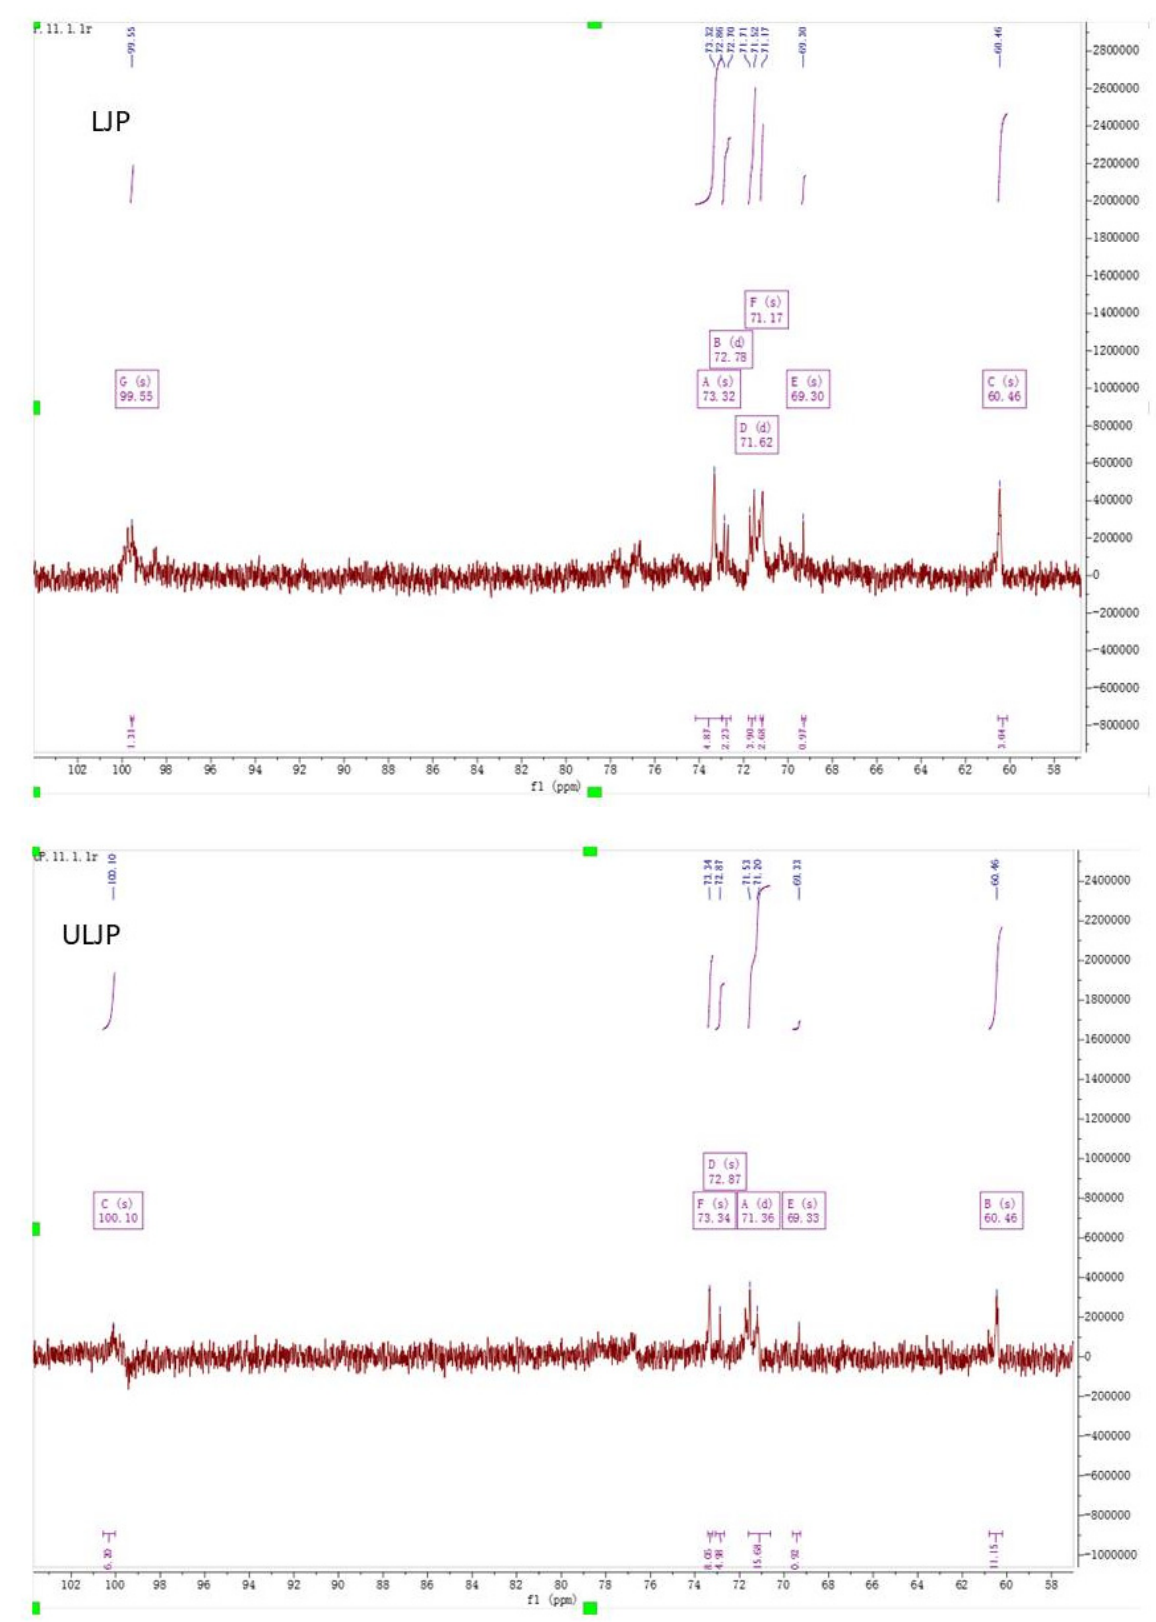
Figure 4. NMR spectra of LJP and ULJP (solvent = D 2 O): 13 C NMR spectrum.